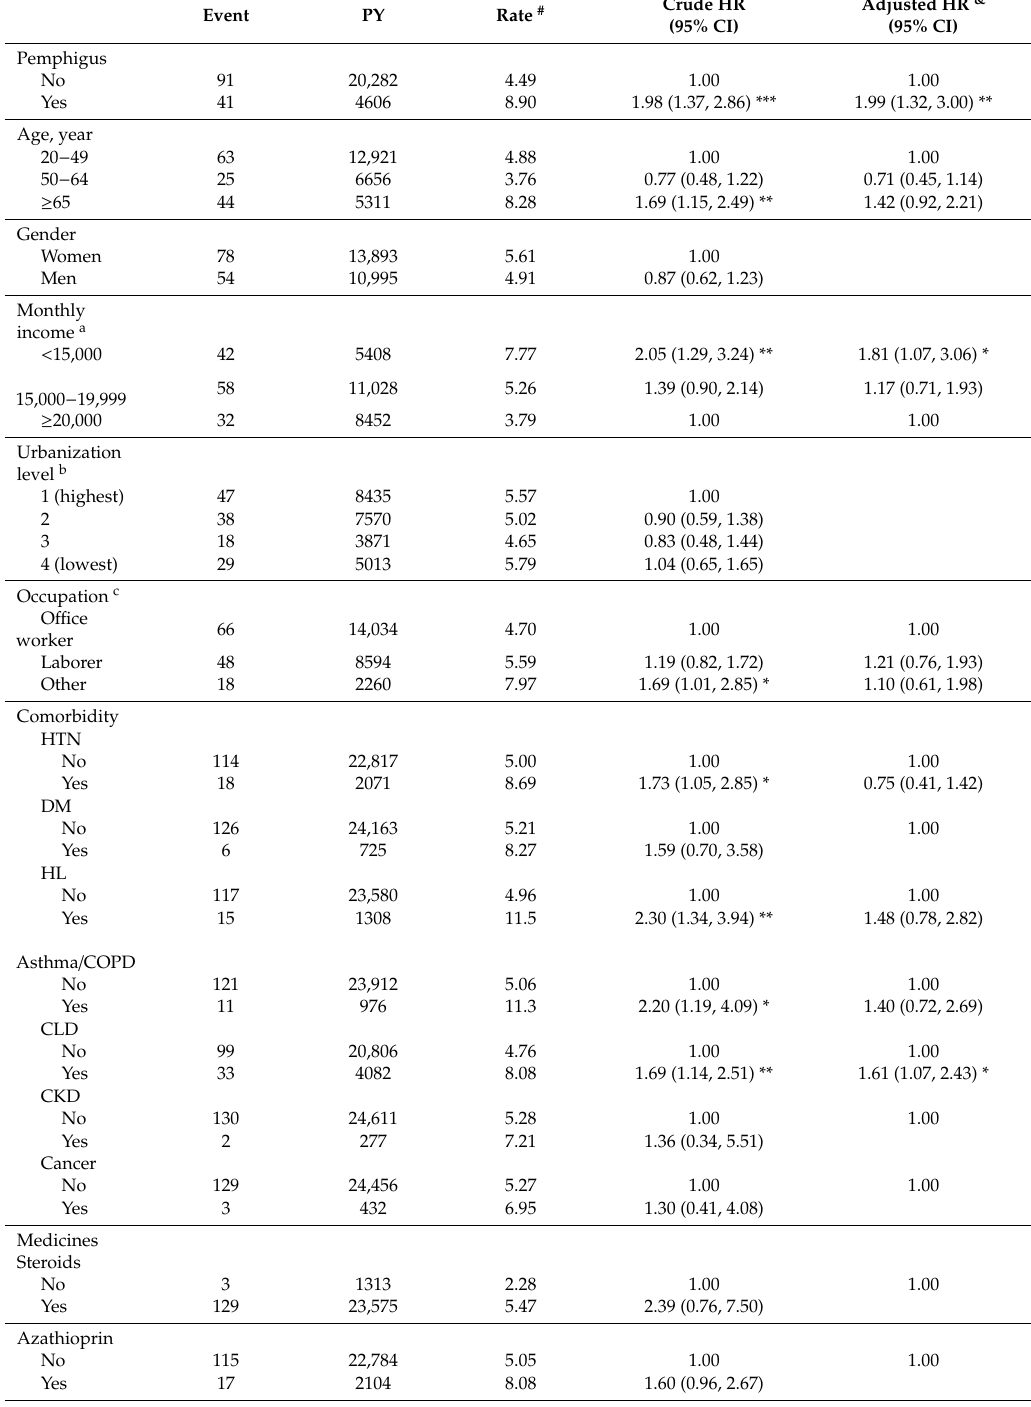
Table 2. The incidence and risk factors for